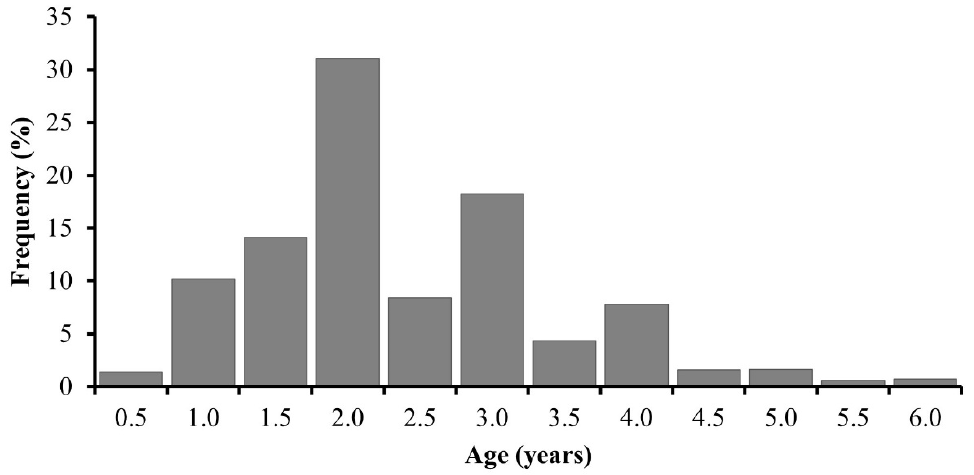
Figure 6. Age (years) frequency distribution of the temperate Sardinops sagax stock in the southern California Current System (CCS) during study period (2005–2014). Table 3. Mean standard length (SL, mm) at age and standard deviation (SD) determined for the temperate Sardinops sagax stock in the southern California Current System (CCS) during the study period (2005–2014) ( n : sampling size).